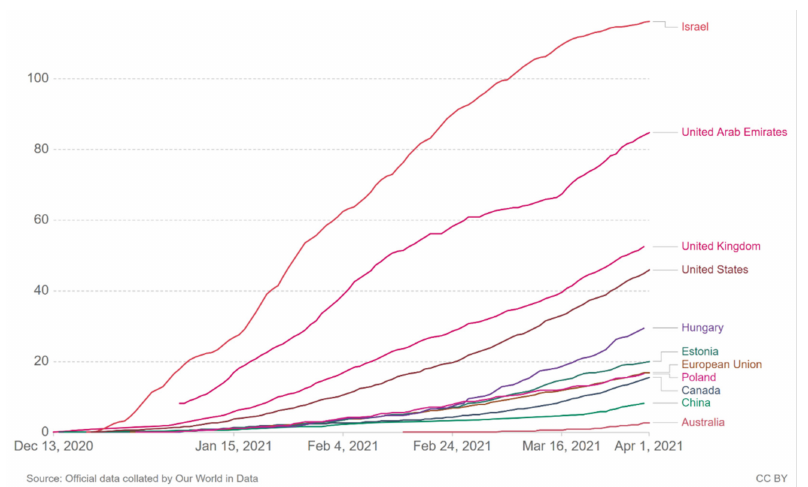
Figure 1. COVID-19 vaccine doses administered per 100 people (1 April 2021) [5]. Total number of vaccination doses administered per 100 people in the total population. This is counted as a single dose and may not equal the total number of people vaccinated, depending on the specific dose regime (e.g., people receive multiple